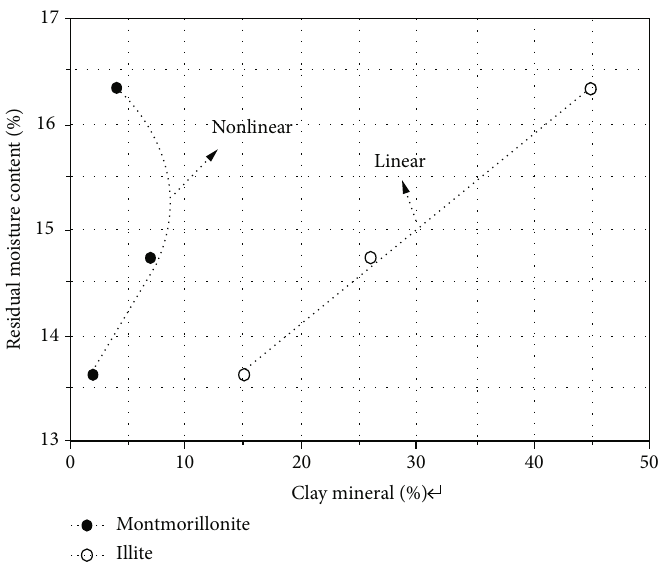
Figure 9: Relationship between residual water content and content of clay fraction.